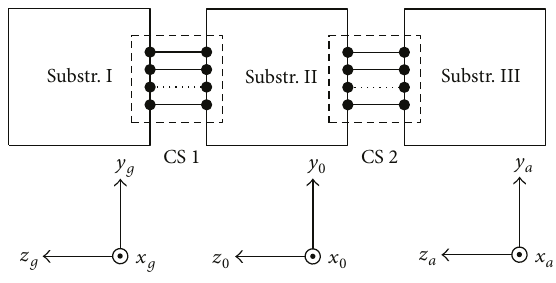
Figure 9: Substructure division of the coupling